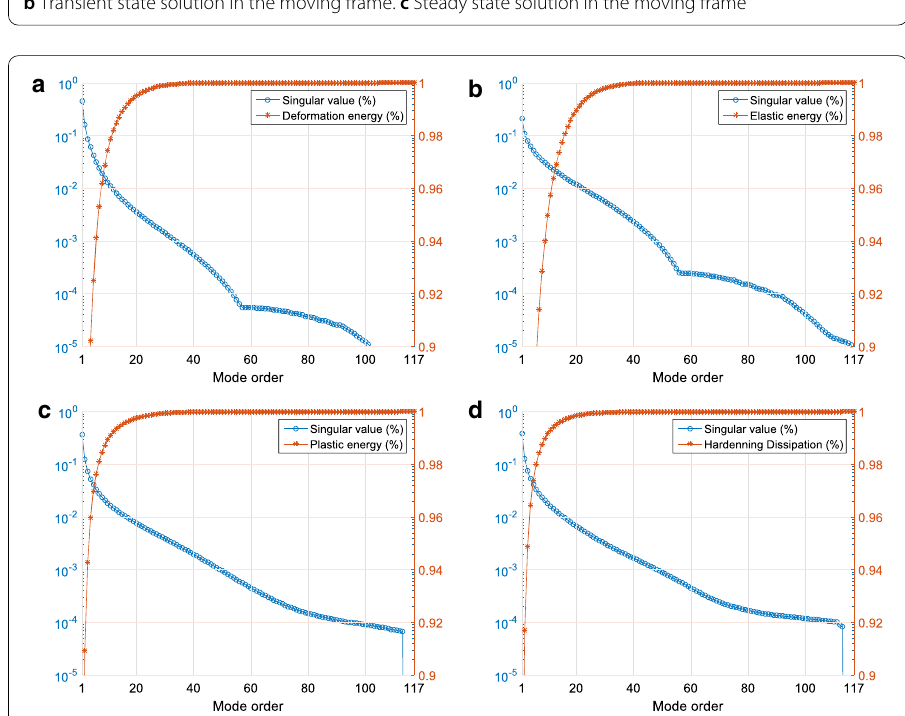
Fig. 9 Modes contribution for mechanical variables. a Modes contribution for U . b Modes contribution for σ . c Modes contribution for ε p . d Modes contribution for